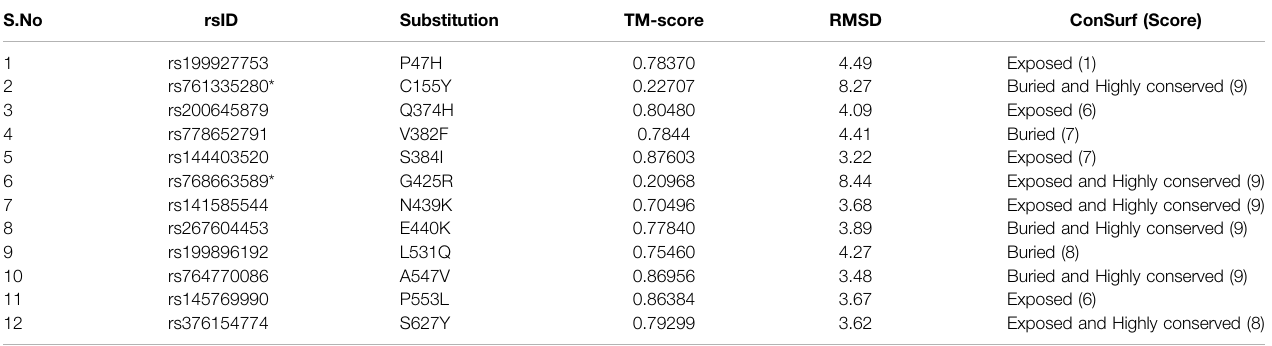
TABLE 5 | TM-align and ConSurf